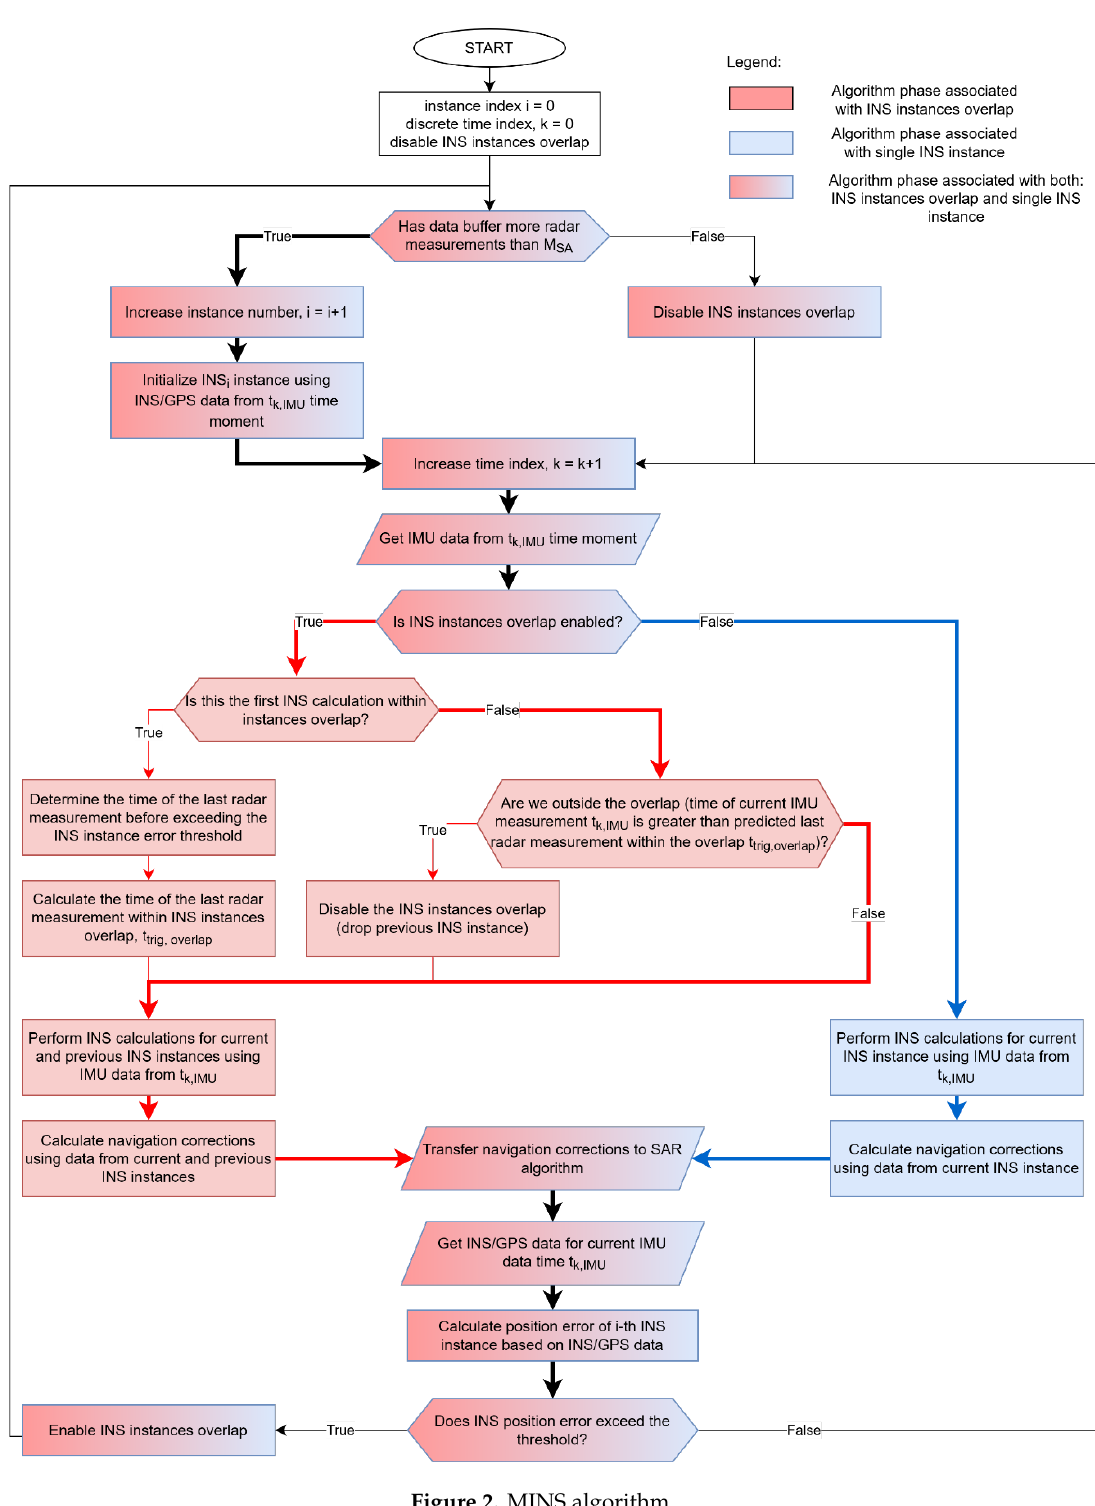
Figure 2. MINS algorithm.